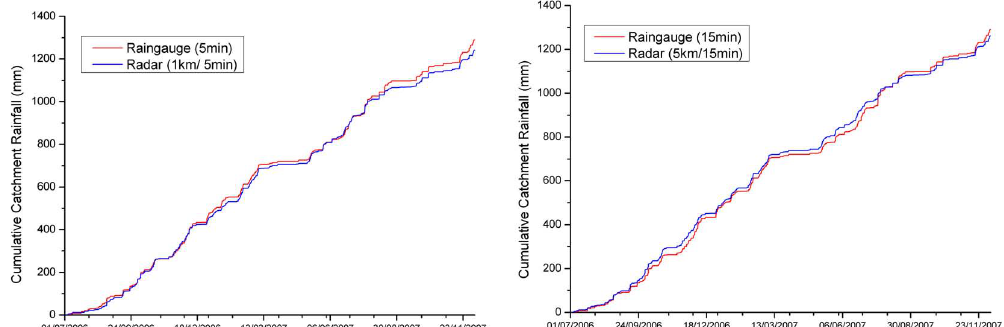
Figure 3. The results of model validation with raingauge rainfall 732